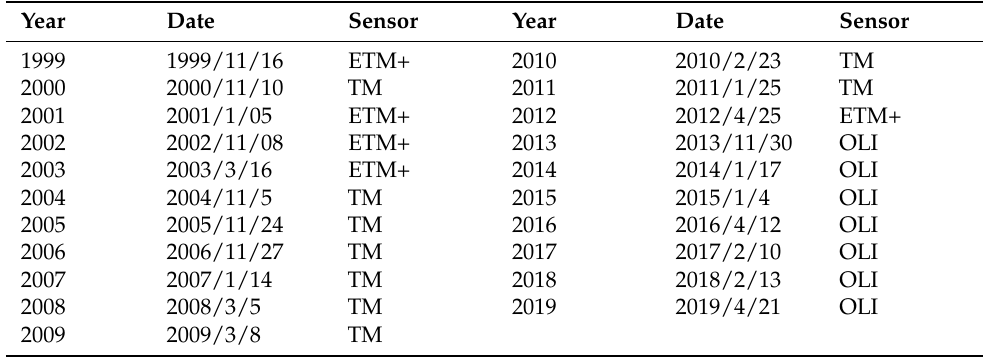
Table 1. List of Landsat images used to build the time-series